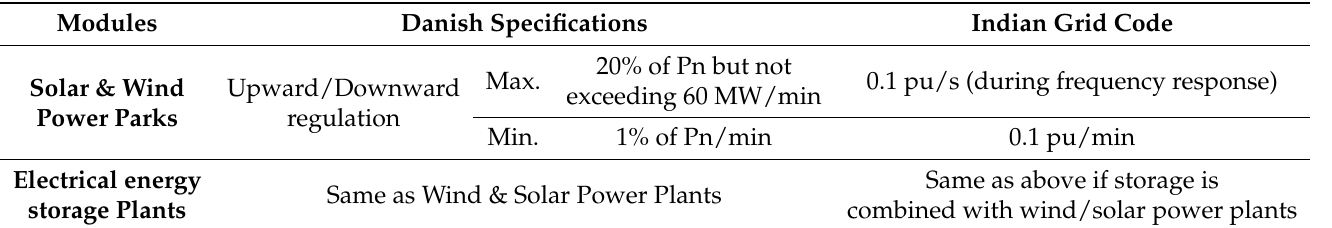
Table 5. Ramp rate limits during upward and downward regulation in Denmark and